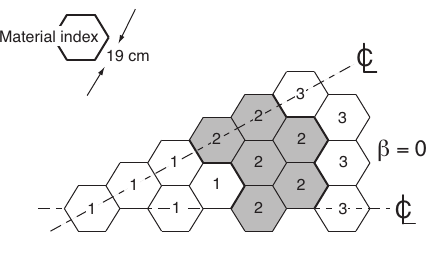
Table 1: Cross-section data for the 2D one-group benchmark shown in Fig. 3. Note the anisotropy in mixture